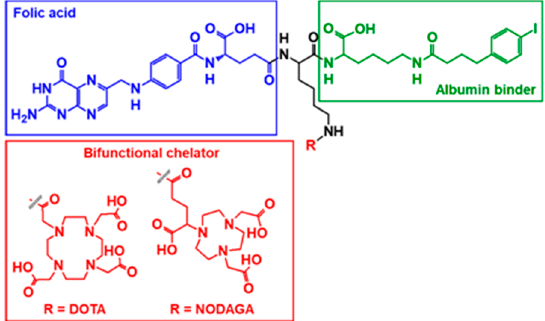
Figure 1. Structures of the albumin-binding folate derivatives cm10 (R = 1,4,7,10-tetraazacyclododecane-1,4,7,10-tetraacetic acid (DOTA)) and rf42 (R = 1,4,7-triazacyclononane, 1-glutaric acid-4,7-acetic acid (NODAGA)). In addition to a bifunctional chelator, each bioconjugate consists of a folic acid molecule for FR-targeting and a p -iodophenyl-based albumin-binding